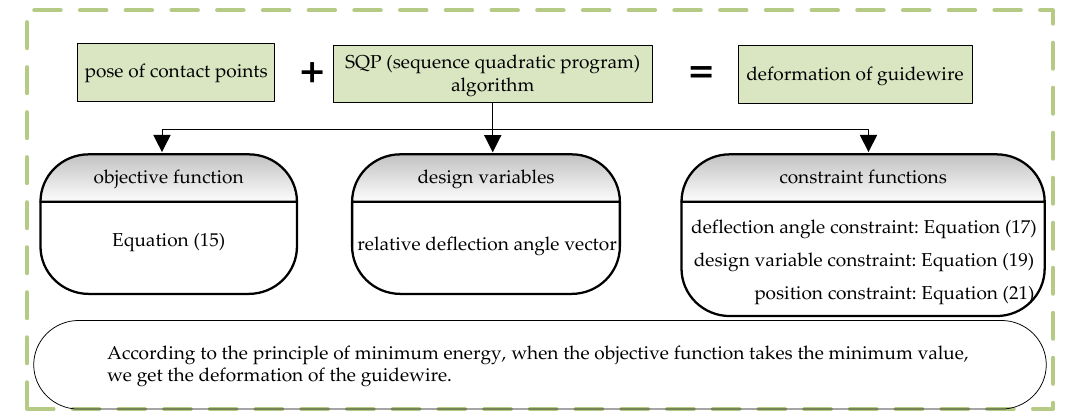
Figure 3. Flow chart of the proposed method.